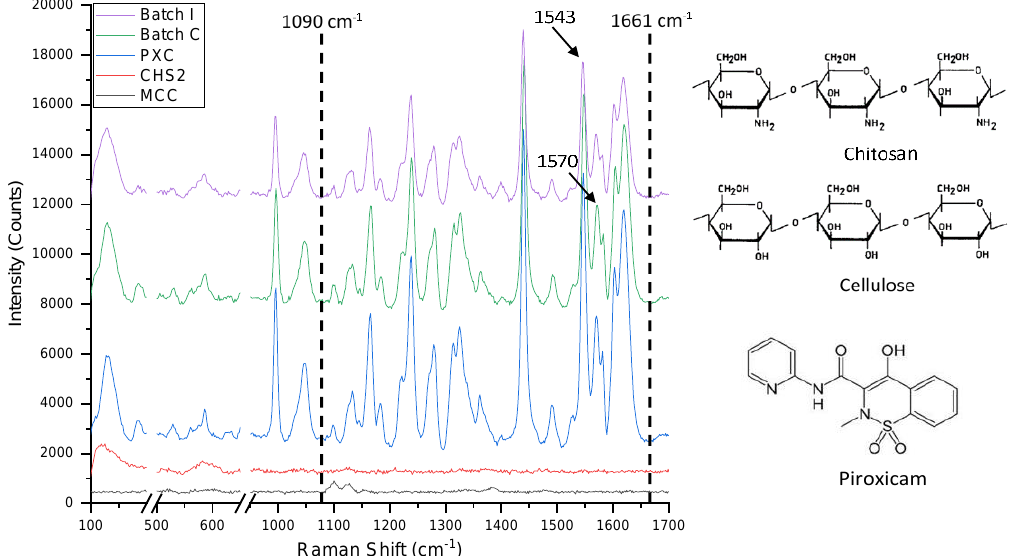
Figure 6. Raman spectra of microcrystalline cellulose (MCC), chitosan (CS2), unprocessed Figure 6. Chemical structures and Raman spectra of microcrystalline cellulose (MCC), chitosan (CHS2), Figure 6. Chemical structures and Raman spectra of microcrystalline cellulose (MCC), chitosan drug (PXC) and experimental batches C (CHS2/MCC 47.5/10, PXC37.5%). and (CHS2/MCC Figure 6. Chemical structures and Raman spectra of microcrystalline cellulose (MCC), unprocessed drug (PXC), and experimental batch I (CHS2 47.5%, MCCI 10%, PXC (CΗS2), unprocessed drug (PXC), and experimental batch I (CHS2 47.5%, MCCI 10%, PXC 37.5%). 10/47.5, PXC37.5%). chitosan (CΗS2), unprocessed drug (PXC) and experimental batch I (CHS2 47.5%, MCCI 10%, PXC37.5%